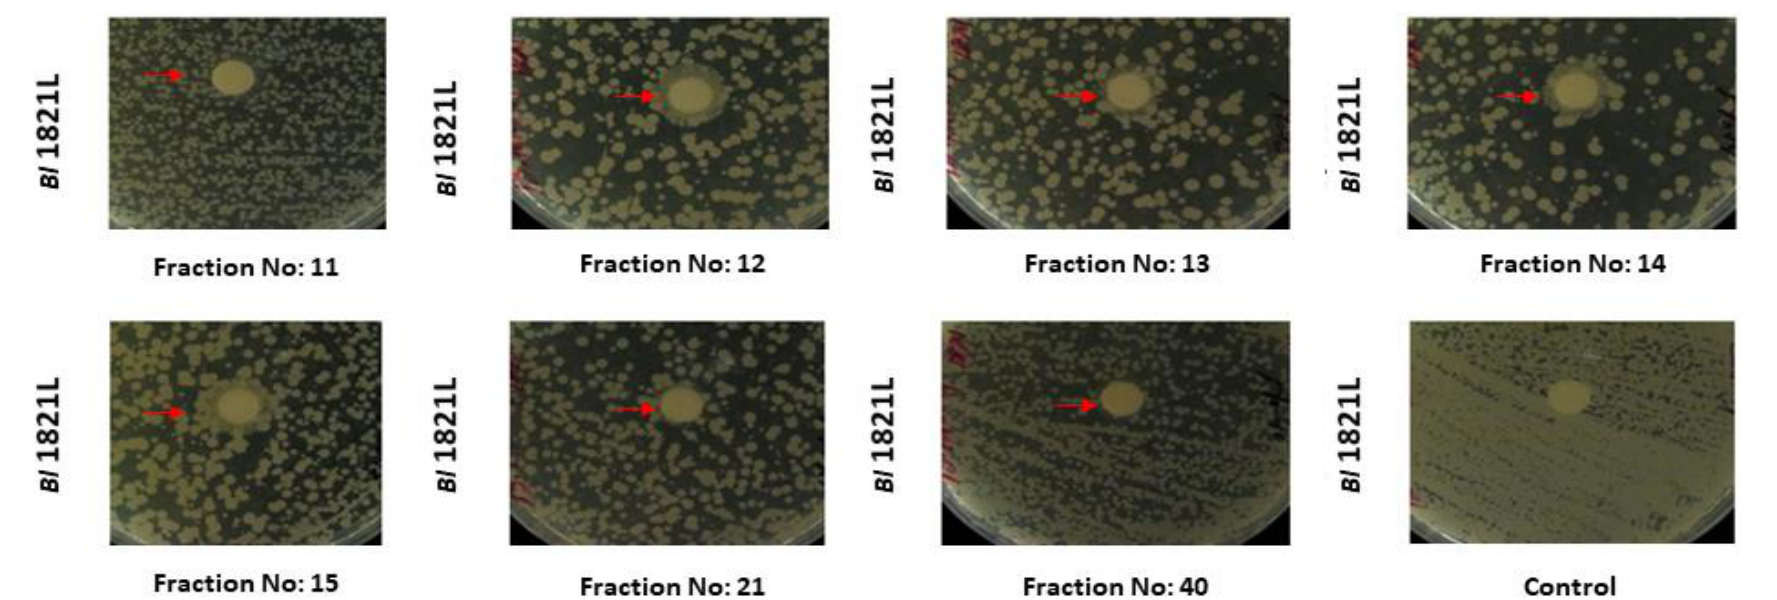
Figure 2. Disc diffusion assay test of Bl 1951 SEC fractions against Bl 1821L as the host bacterium. The red arrow denotes the formed persister cells.